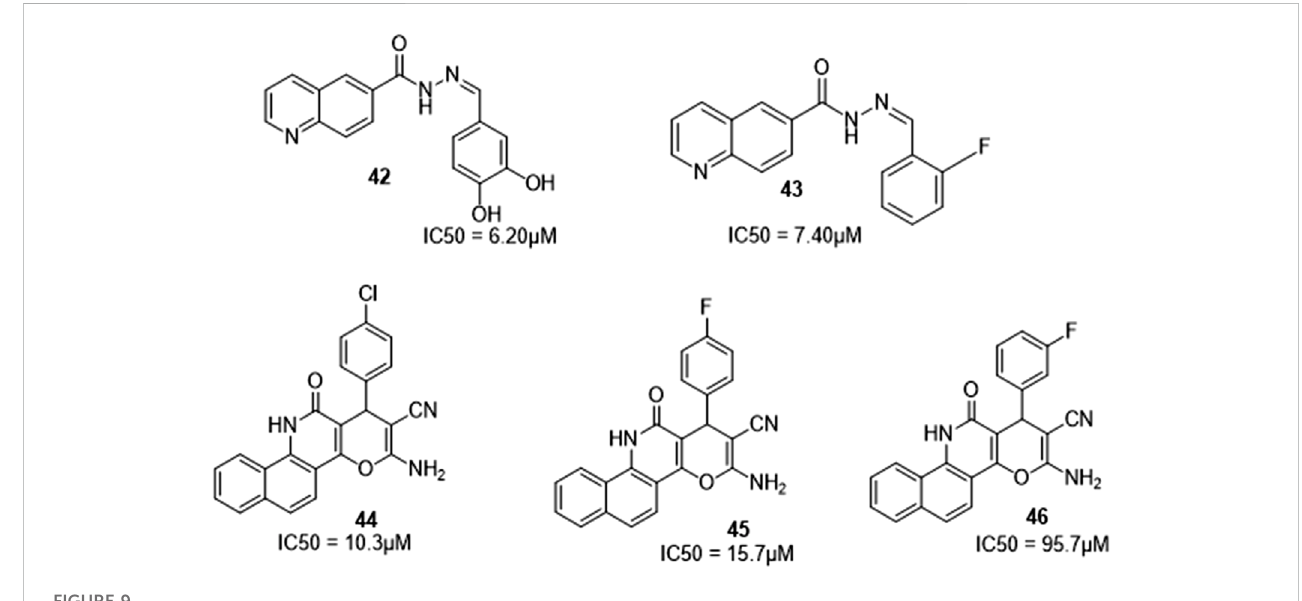
FIGURE 9 Quinoline hybrids with a-glucosidase inhibitory activity.